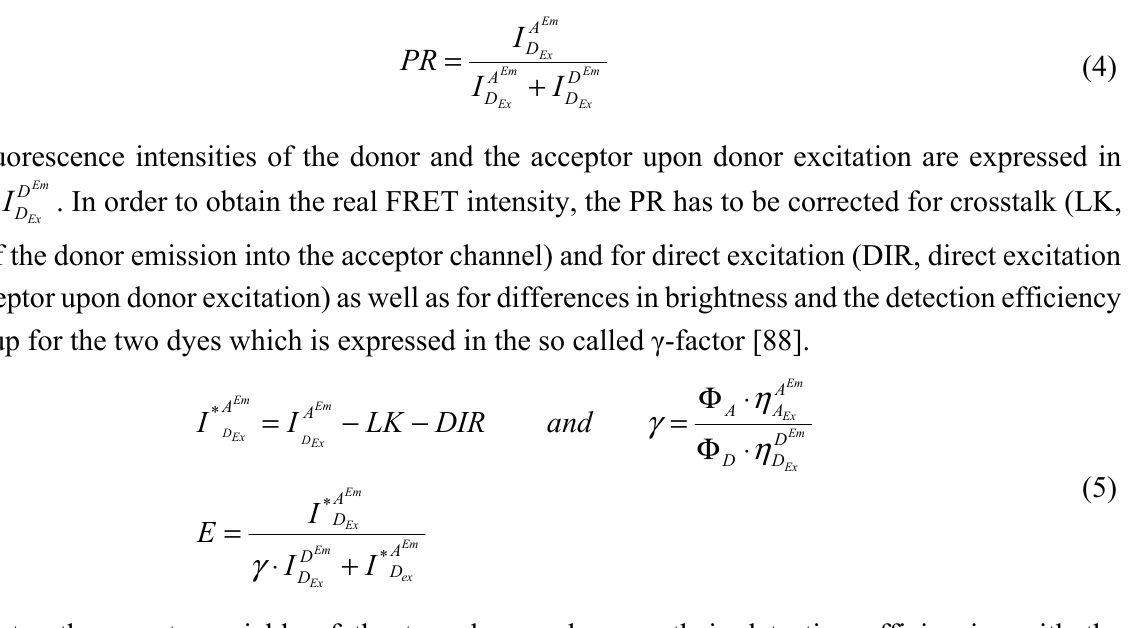
Figure 7. Analysis of single-molecule data to retrieve quantitative distance